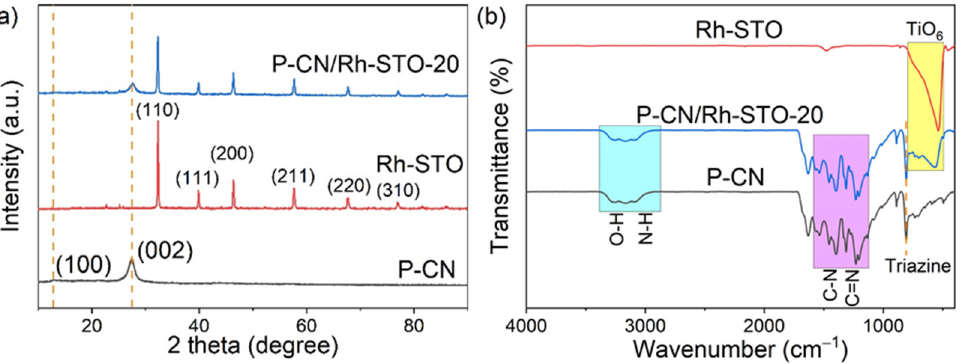
Figure 1. ( a ) XRD patterns and ( b ) FT-IR spectra of P-CN, Rh-STO, and P-CN/Rh-STO-20, respectively.